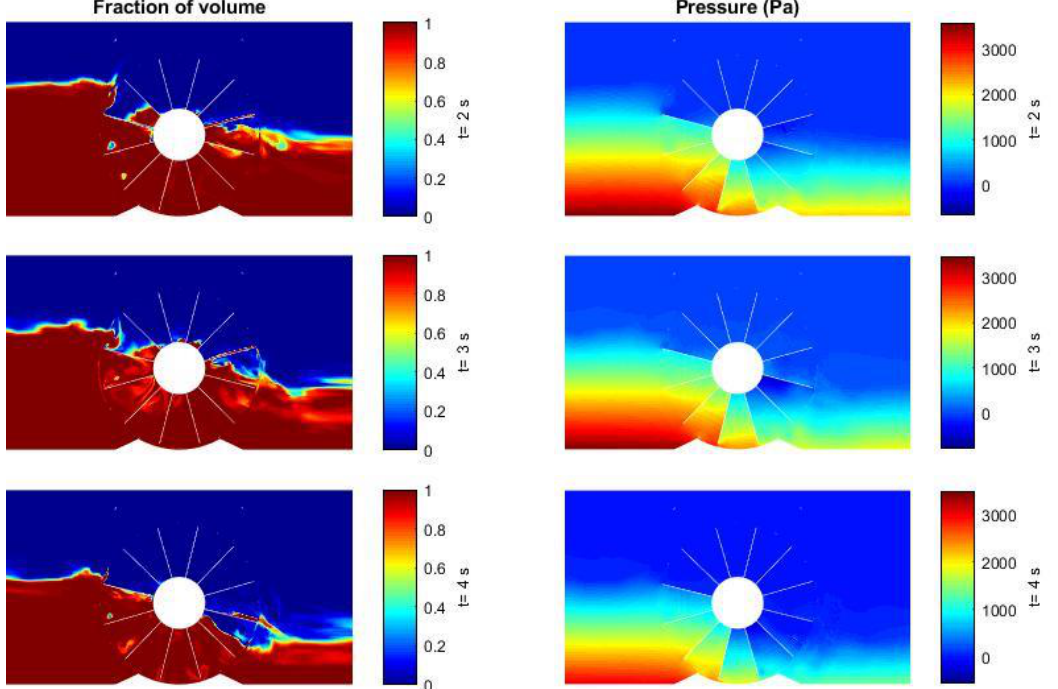
Figure 18. Sequence of fraction of volume ( left ) and pressure ( right ) around the HPM at times t = 2 s ( up ), 3 s ( middle ) and 4 s ( down